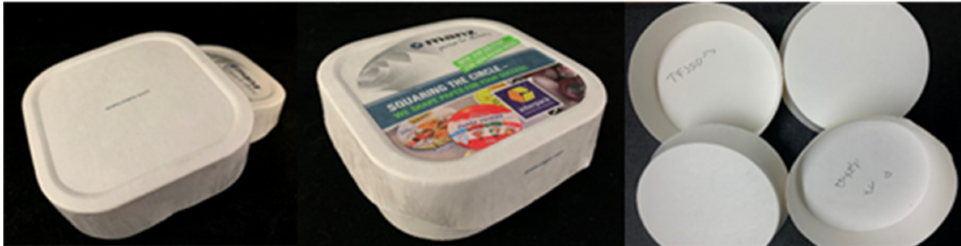
Figure 2. Examples of new paper-based packaging materials discussed in Stage